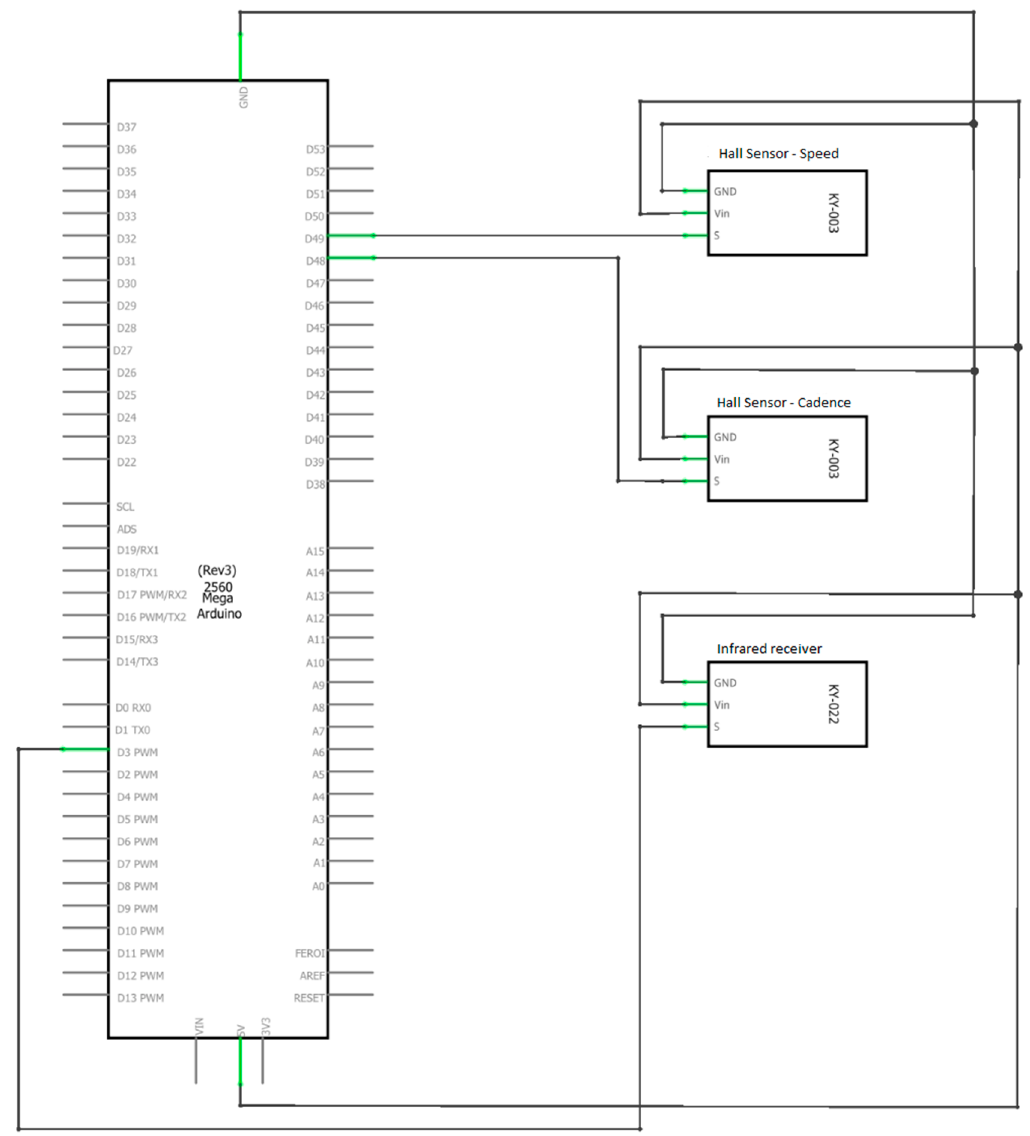
Figure 4. Bike frame module wiring diagram.